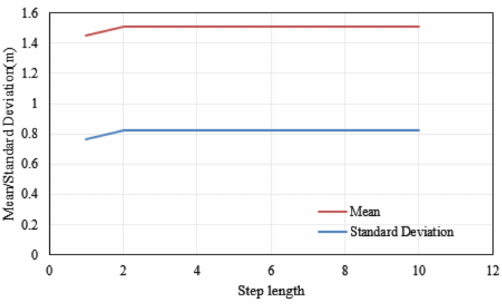
Figure 12. Distributions of the mean and standard deviation different steps as the memory window.